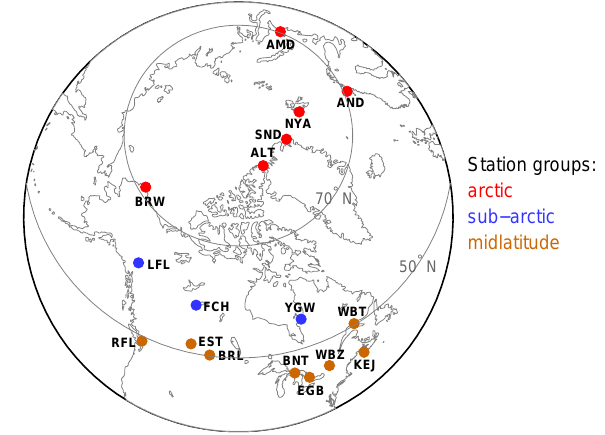
Fig. 1. Locations of verification stations. See Table 1 for station